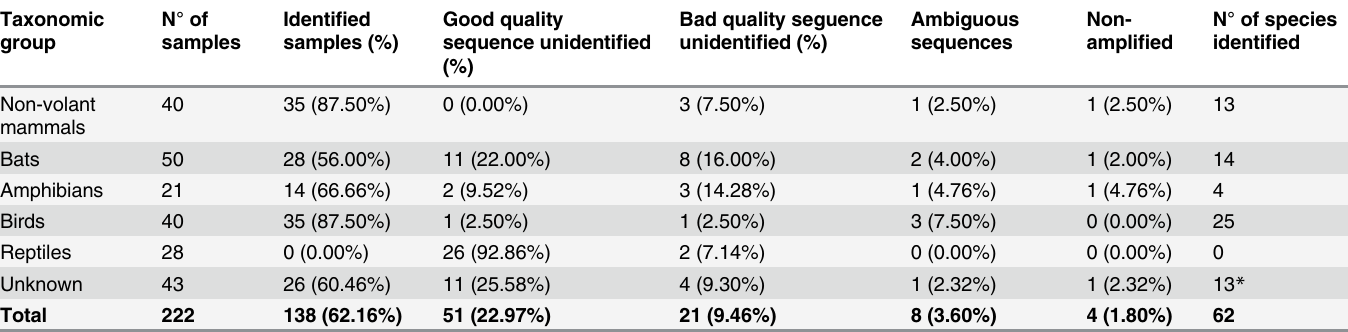
Table 1. Number of identified and unidentified species (and percentages) classified in taxonomic groups.